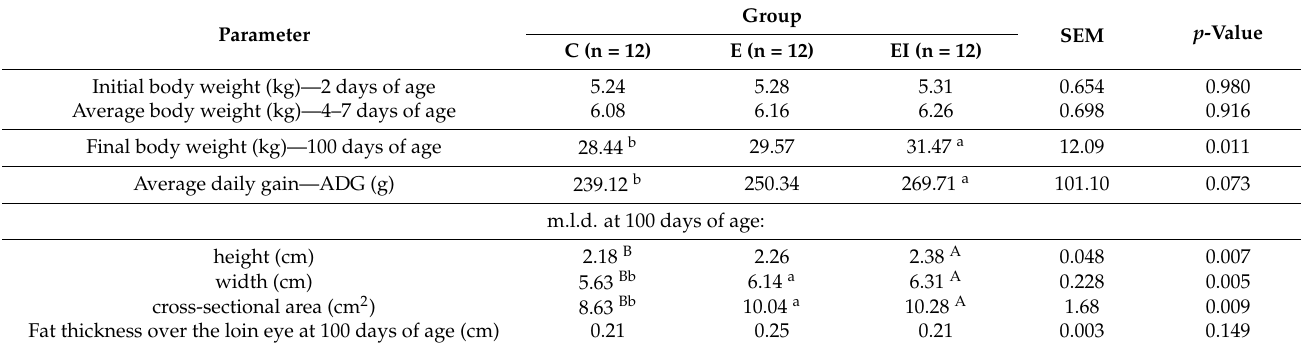
Table 6. Body weights, average daily gain, and the results of ultrasonic measurements performed in lambs. Parameter